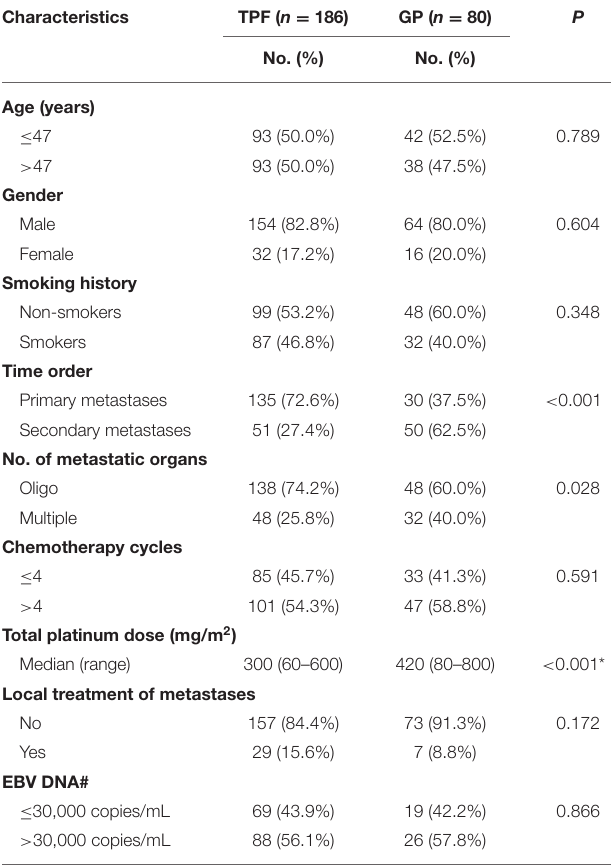
TABLE 1 | Clinical characteristics in whole cohort.